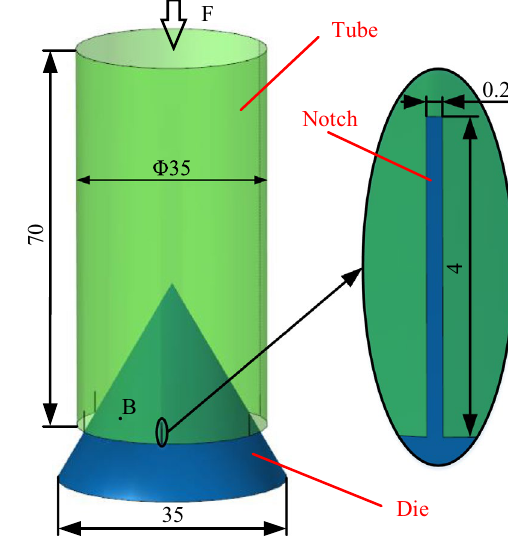
Figure 9 Sketch of the combined splitting circular tube energy absorber (unit: